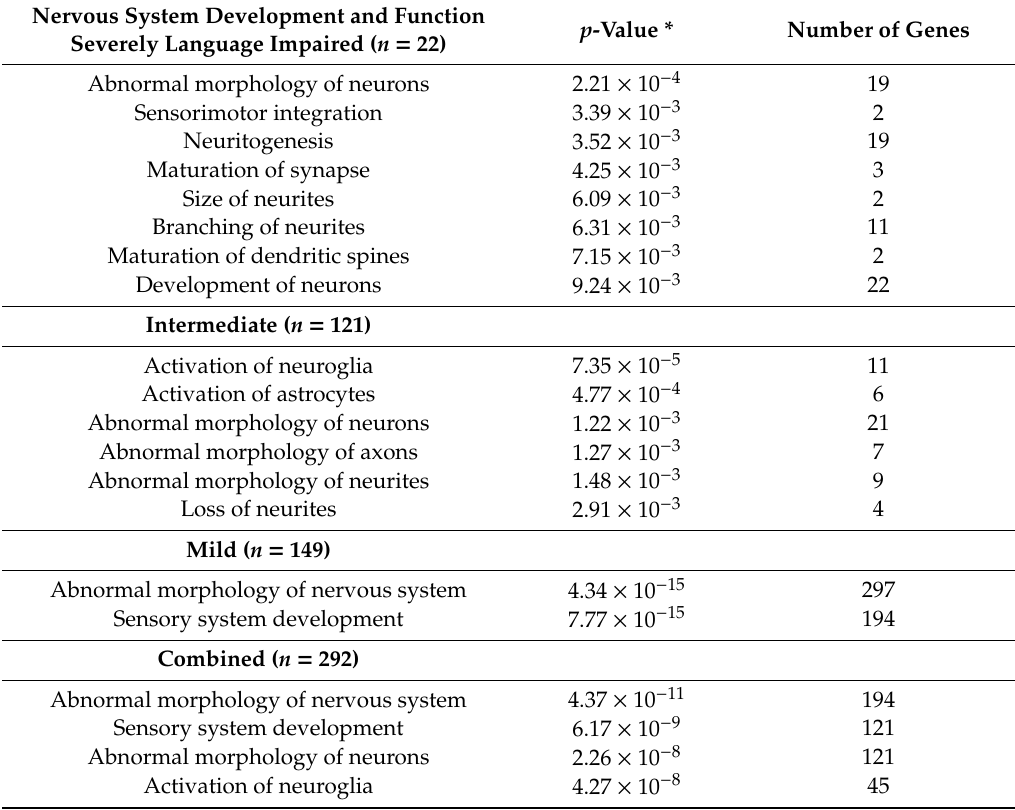
Table 1. Significantly over-represented neurological functions among DAGs from three phenotypic subgroups of ASD and a combined case